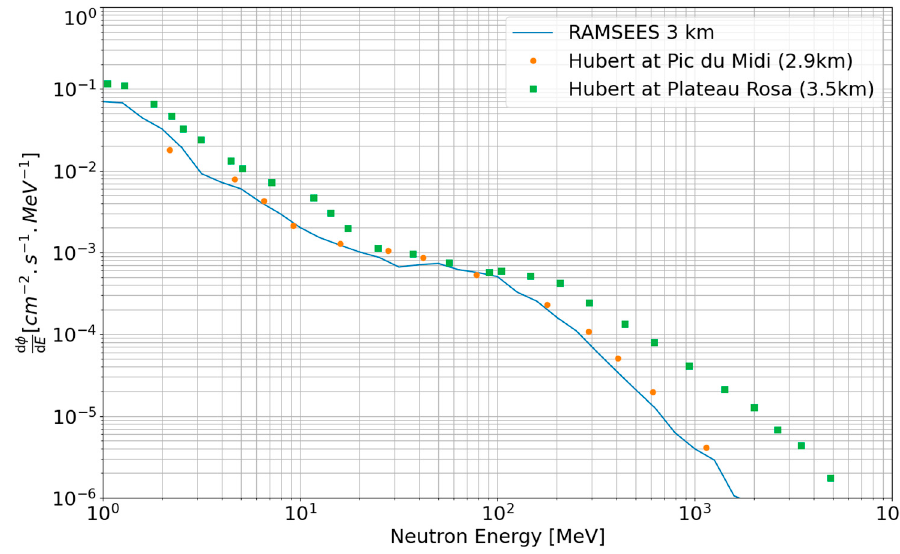
Figure 14. Comparison between RAMSEES results at 3 km and experimental data at 2.9 and 3.5 km from Hubert et al. [40].